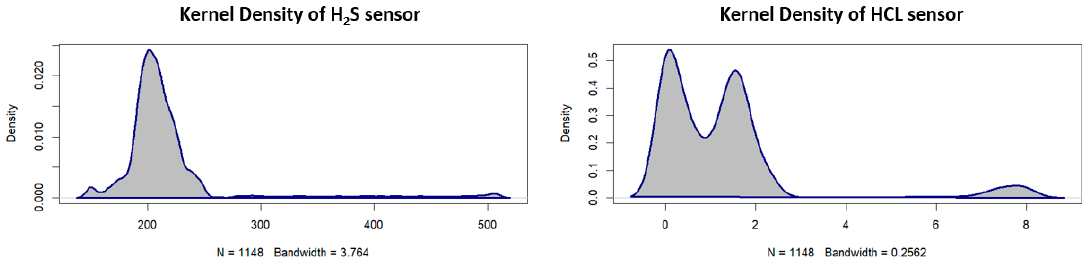
Figure A2. Kernel density for first ground measurement (PM 1.0 sensor, PM 2.5 sensor, PM 10 sensor, C X H Y sensor).